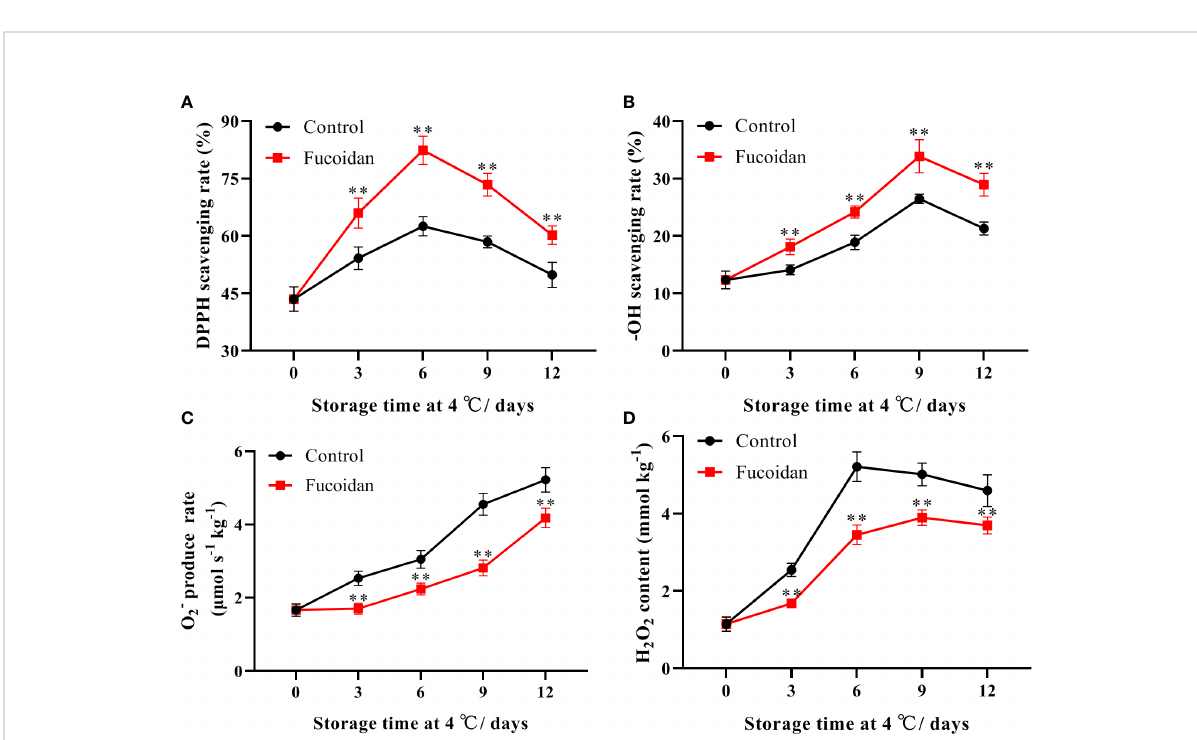
FIGURE 2 (A-D) The DPPH scavenging rate (A) , -OH scavenging rate (B) , O − 2 production rate (C) , and H 2 O 2 content (D) in fucoidan-treated (15 g L -1 ) and control cucumbers during storage at 4°C. Values are presented as means ± SD of at least three replicates. **P<